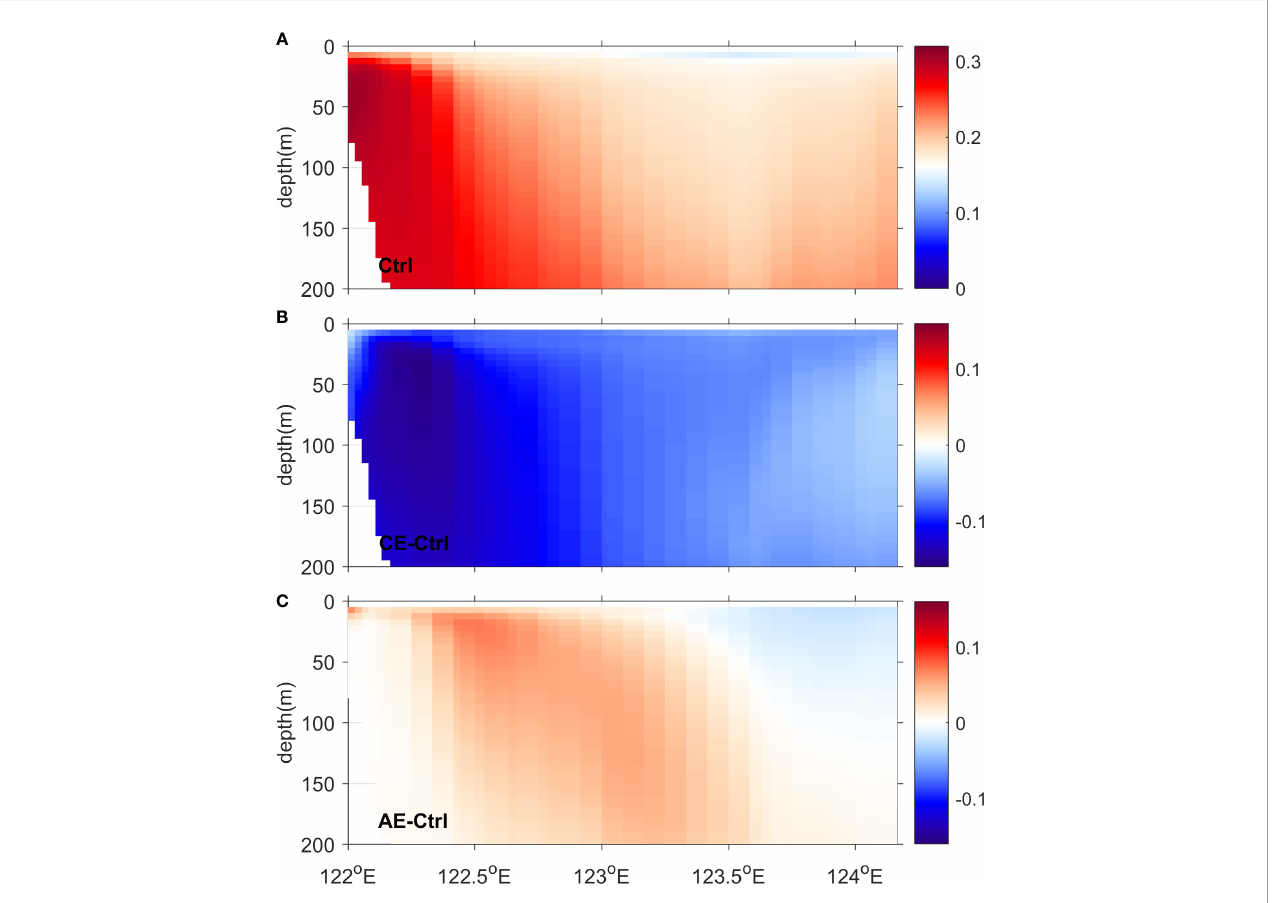
FIGURE 11 The phosphate concentration (kg/m 3 ) along the 200 m isobaths in the (A) Ctrl experiment, and their variations under the in fl uence of (B) cyclonic and (C) anticyclonic eddies at t=30